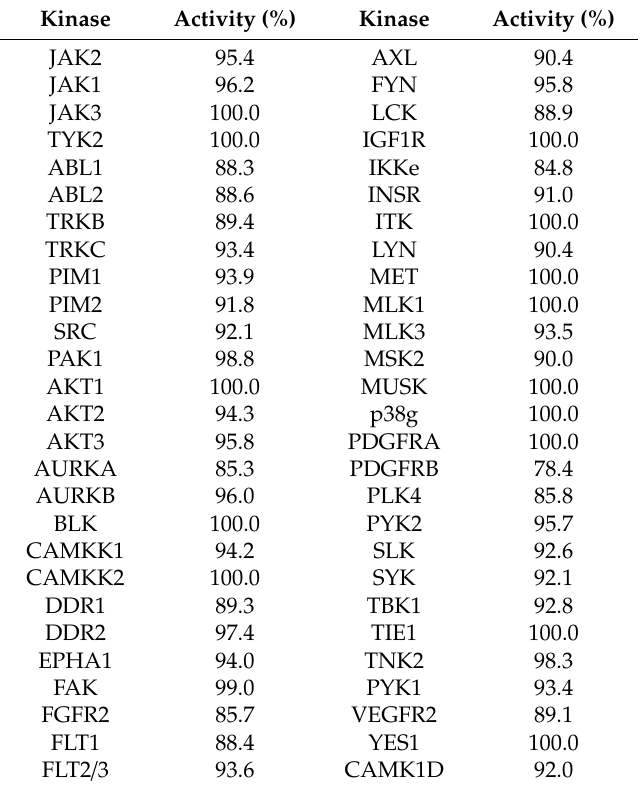
Table 1. Inhibitory activity of IST5 (1 µ M) against a panel of 54 kinases. Kinase Activity (%) Kinase Activity (%)